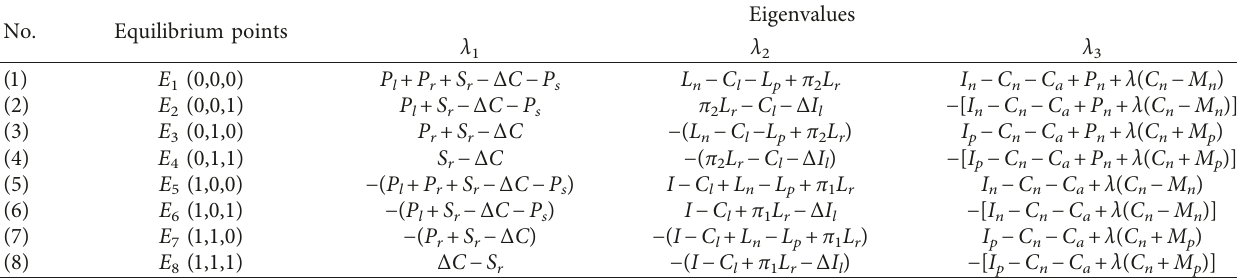
Table 3: System eigenvalues under different equilibrium points.